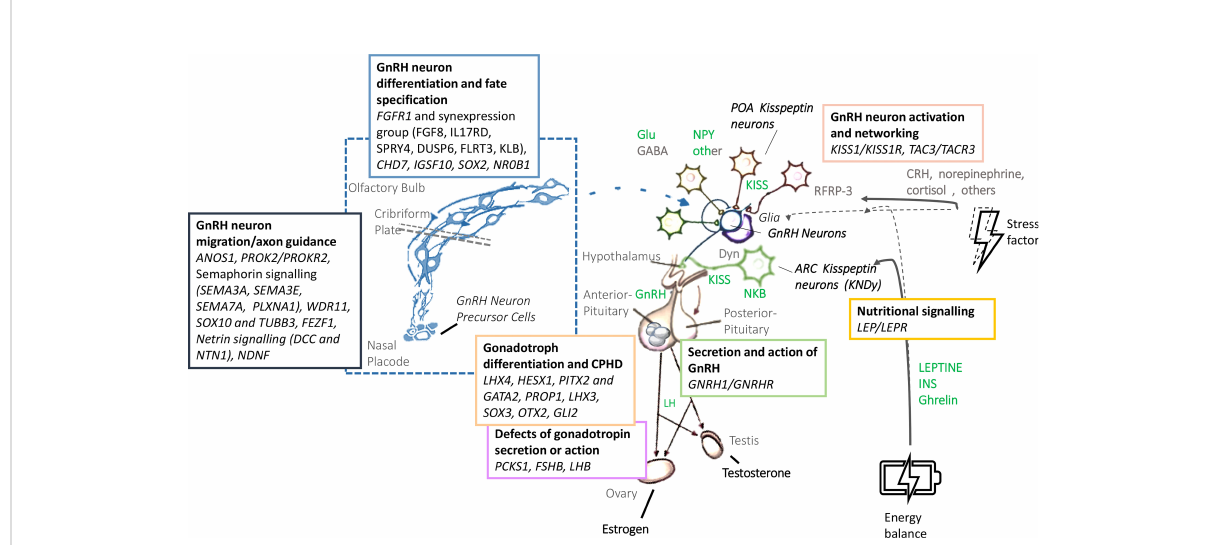
FIGURE 1 Biology and genetic background of the GnRH neuronal system. GnRH, gonadotropin-releasing hormone; LH, Luteinizing Hormone; FSH: Follicle-Stimulating Hormone; Glu, glutamate; GABA, gamma-amino-butyric acid; NPY, neuropeptide Y; POA, preoptic area; KISS, Kisspeptin; NKB, neurokinin B; Dyn, dynorphin; CRH, cortitropin releasing hormone; ARC, arcuate nucleus; INS,